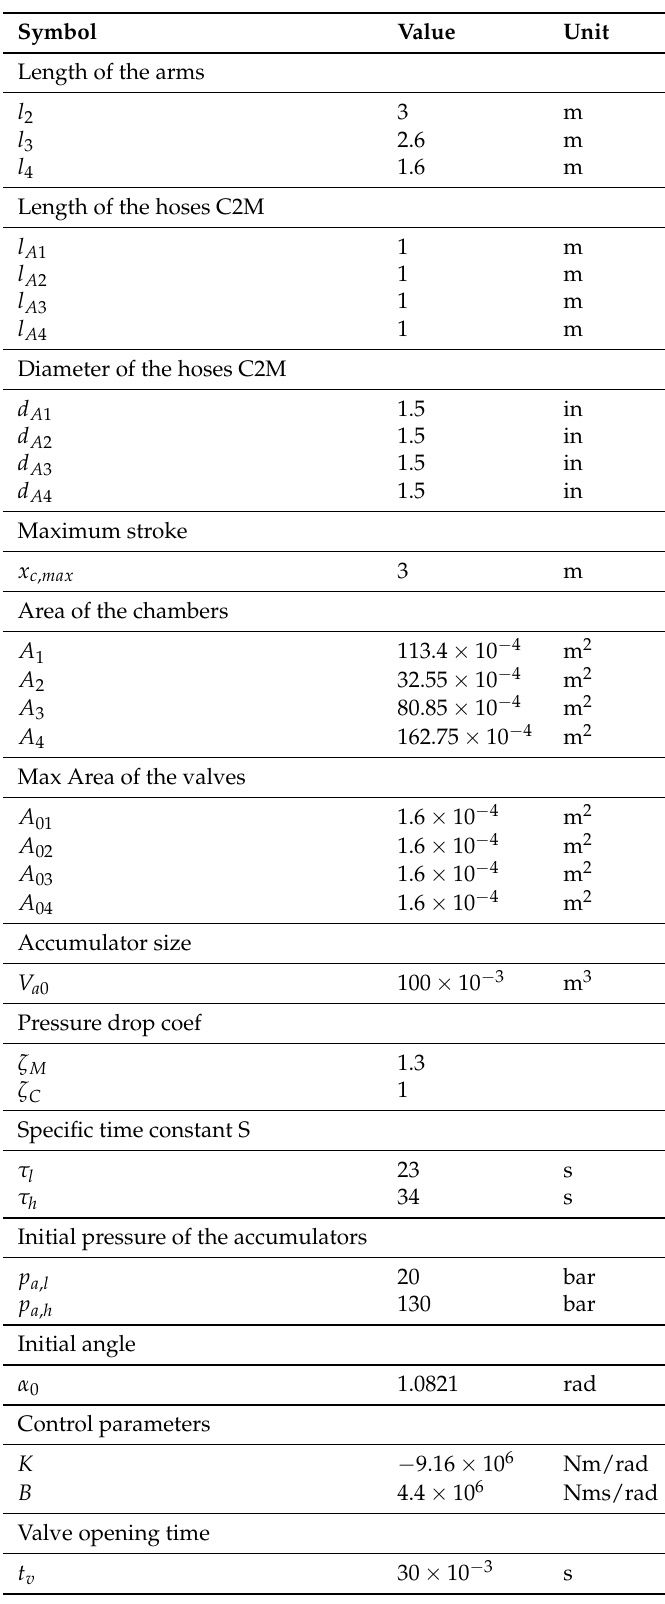
Table 2. The data used in the simulation of the overall WEC